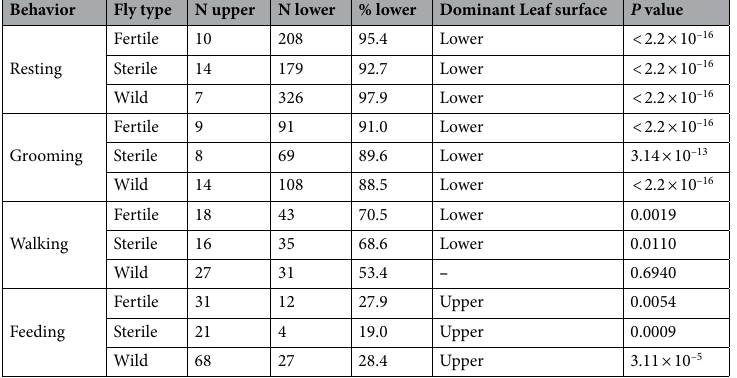
Table 4. Binomial test results of leaf surface (upper = adaxial and lower = abaxial) by fly type and common behaviors. P values were calculated based on the null hypothesis of equal probability ( P = 0.5) that flies occurred on either upper or lower leaf